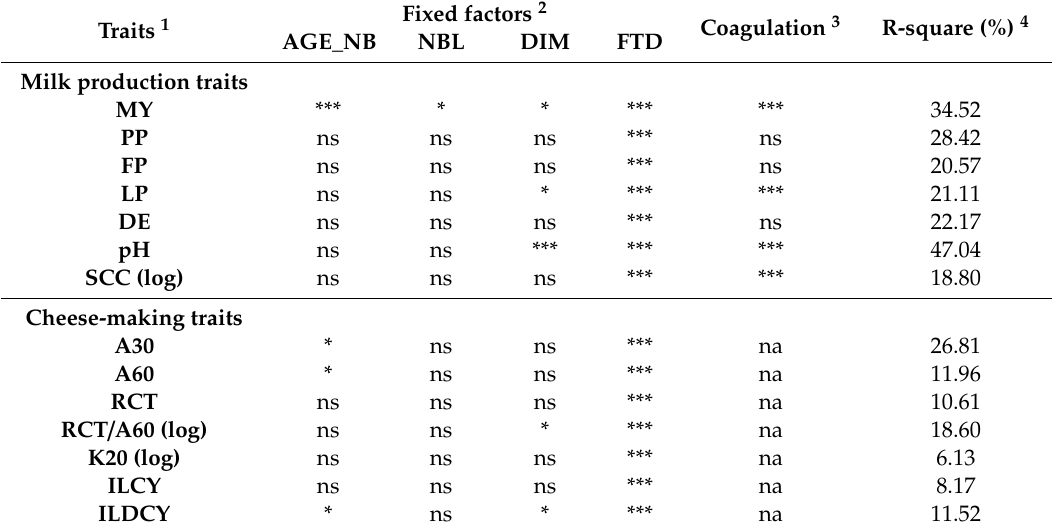
Table 1. Results of the multifactorial ANOVA applied to the milk and cheese-making traits analysed in the present study. Traits 1 Milk production traits